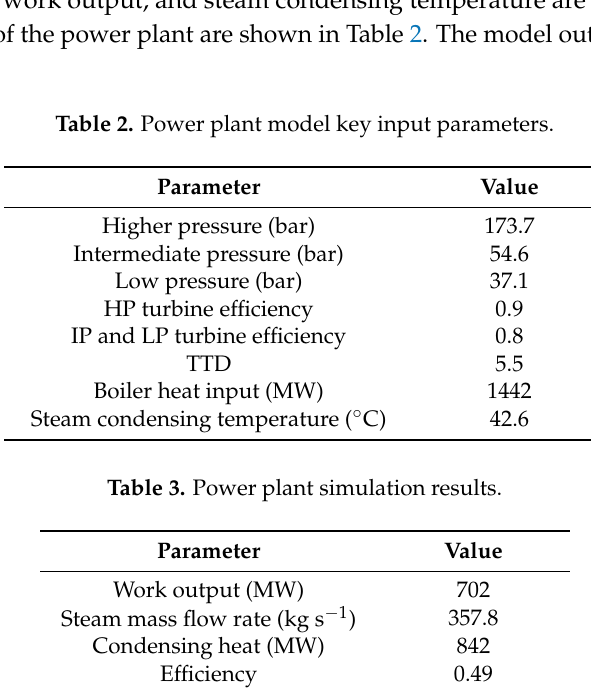
Table 2. Power plant model key input parameters.